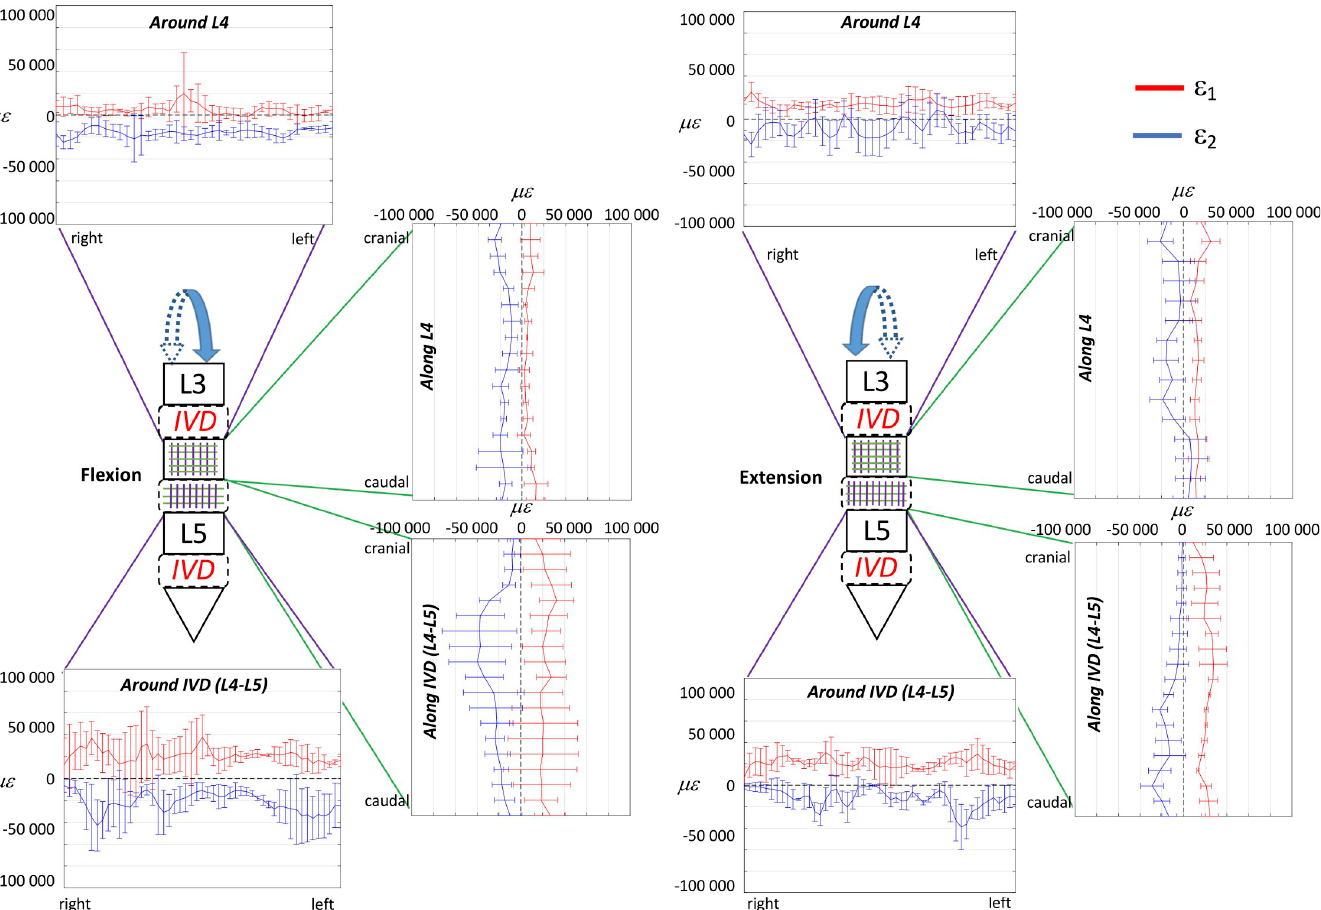
Fig 3. Flexion and extension at the maximum loading (7.5 Nm): to describe the strain distribution of the ALL in the circumferential direction, the median over cranio-caudal lines were computed in the sub-ROI in front of the L4 vertebra and in the sub-ROI in front of the L4-L5 IVD. Similarly, to describe the strain distribution of the ALL in the cranio-caudal direction, the median over circumferential lines were computed in the sub-ROI in front of the L4 vertebra and in the sub- ROI in front of the L4-L5 IVD. The plots show the distribution ofeps 1 (red) and eps 2 (blue) circumferentially the L4 and the IVD (purple lines) and in the cranio-caudal direction of L4 and the IVD (green lines). The median and standard deviation within the five specimens are